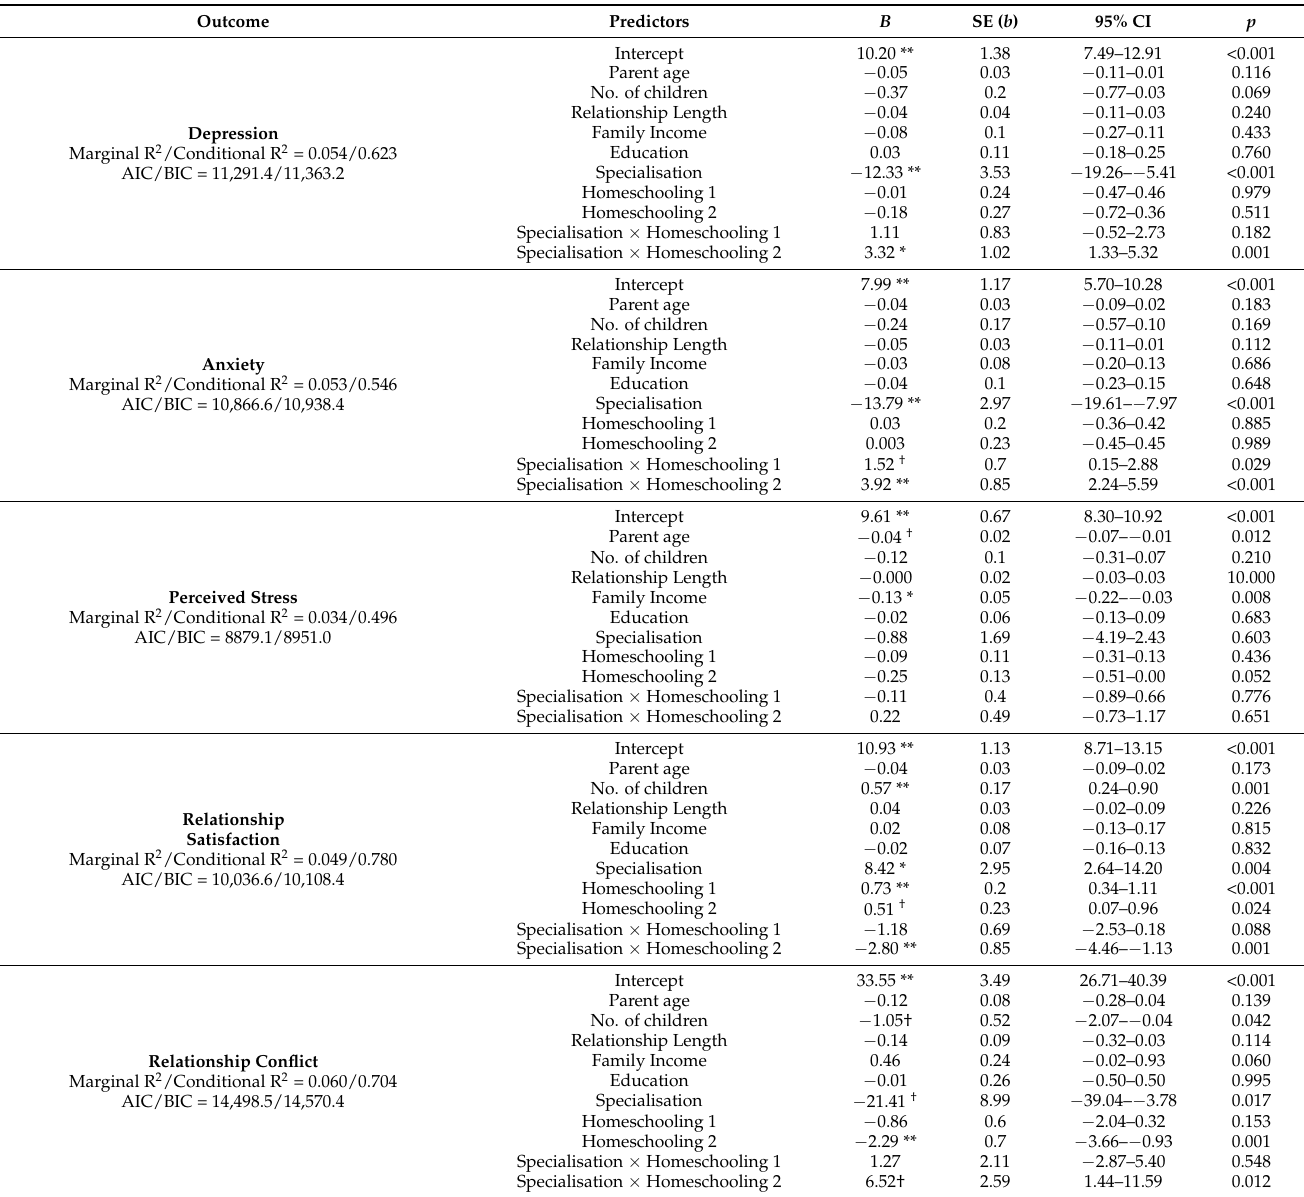
Table 7. Effects of specialisation and homeschooling status on parents’ well-being. Outcome